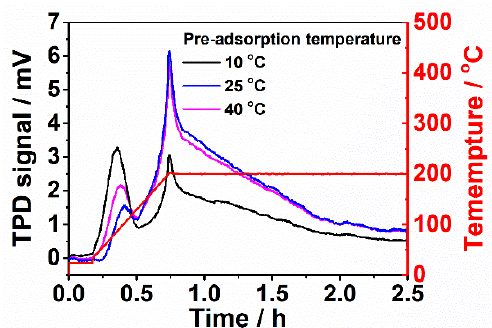
Figure 7. CO 2 TPD response curves of Cu 3 (BTC) 2 -PIL-NH 2 for pre-adsorption of CO 2 at different temperatures. Red line in the figure refers to the temperature profile for desorption.